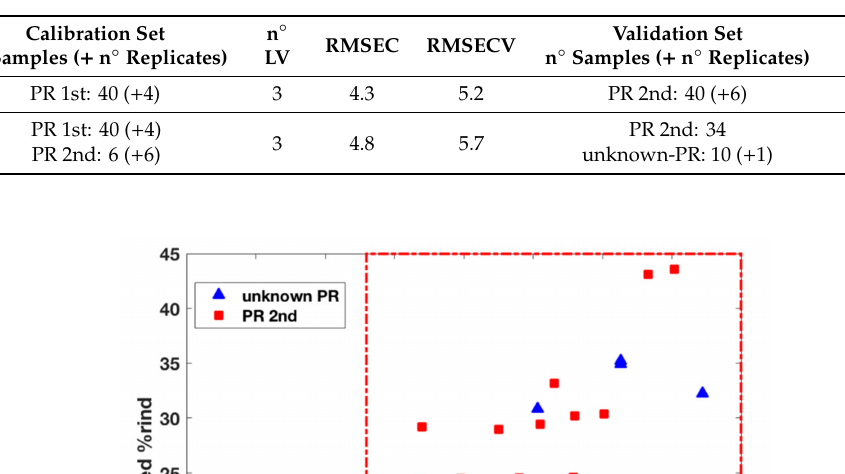
Figure 5. Partial least squares regression (PLS) calibration model for % rind content based on the first sampling set: Measured vs. Predicted rind values. PR 1st samples: black diamonds; PR 2nd set samples: red squares. Table 3. PLS results.